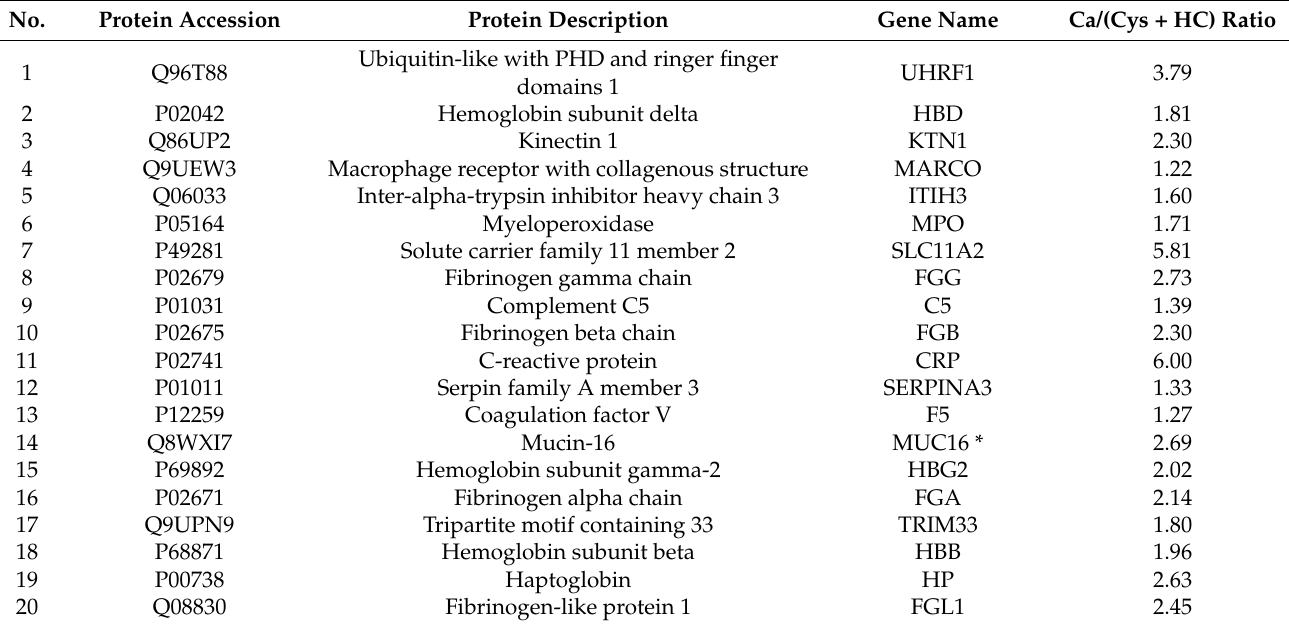
Table 1. The upregulated DEPs existed in both Ca/Cys group and Ca/HC group (>1.2 fold).